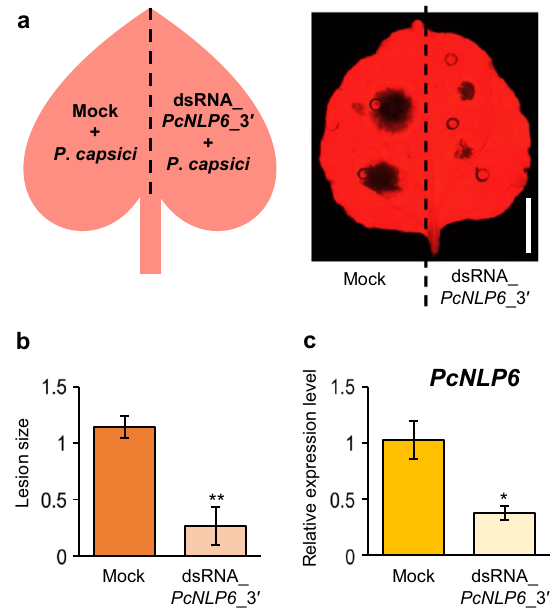
Fig. 3 Suppression of P . capsici infection and PcNLP6 expression via PcNLP6 -targeting dsRNA. a The left figure shows the scheme of dsRNA treatment and P . capsici infection, and the right figure shows the phenotype result of P . capsici infection after treatment with mock and dsRNA_ PcNLP6 _3 ′ , respectively, in 3 week-old N . benthamiana leaves using FOBI. Scale bar 1 cm. b Quantification of = P . capsici infection lesion size using ImageJ. c Quantification of PcNLP6 transcript level using qRT-PCR. Mock: Treated with dsRNA targeting Renilla luciferase . dsRNA_ PcNLP6 _3 ′ : Treated with dsRNA_ PcNLP6 _3 ′ . Data represent mean SEM ( N 3). Significance is determined by ± = Student’s t -test, * P < 0.05 and ** P <